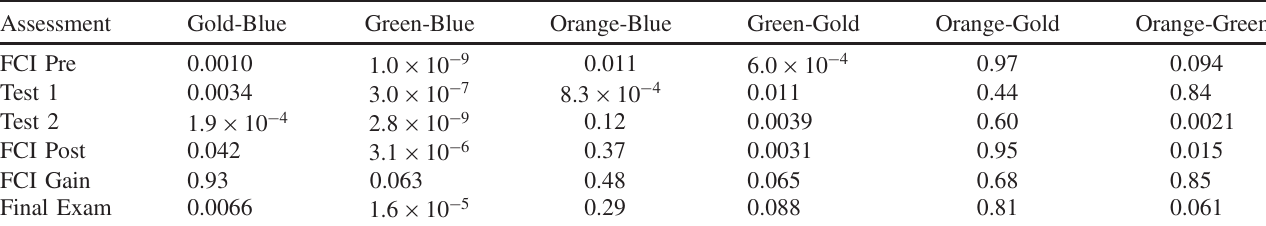
TABLE XIII. p values for Tukey ’ s honest significance test for pairs of